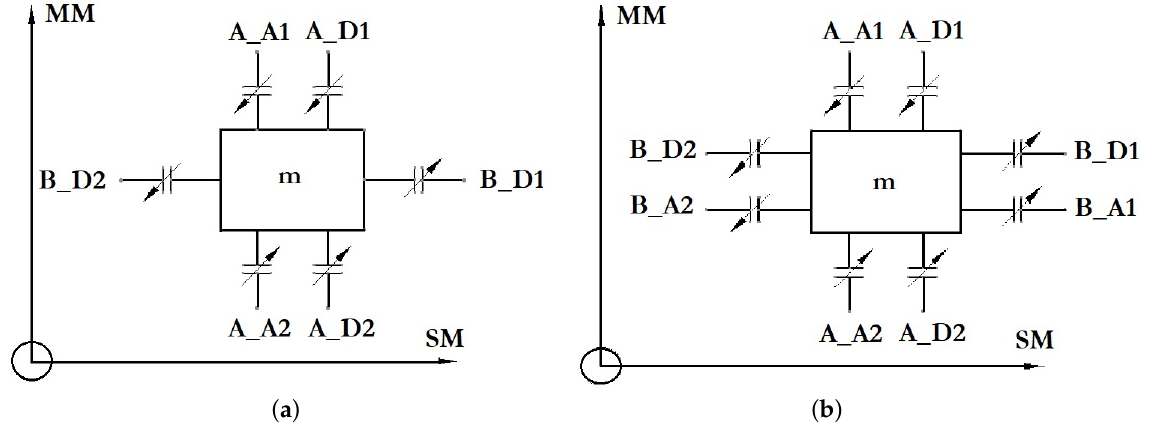
Figure 3. Scheme of the SE of the MEMS gyroscope for ASIC SWS1110: ( a ) open-loop structure; ( b ) closed-loop